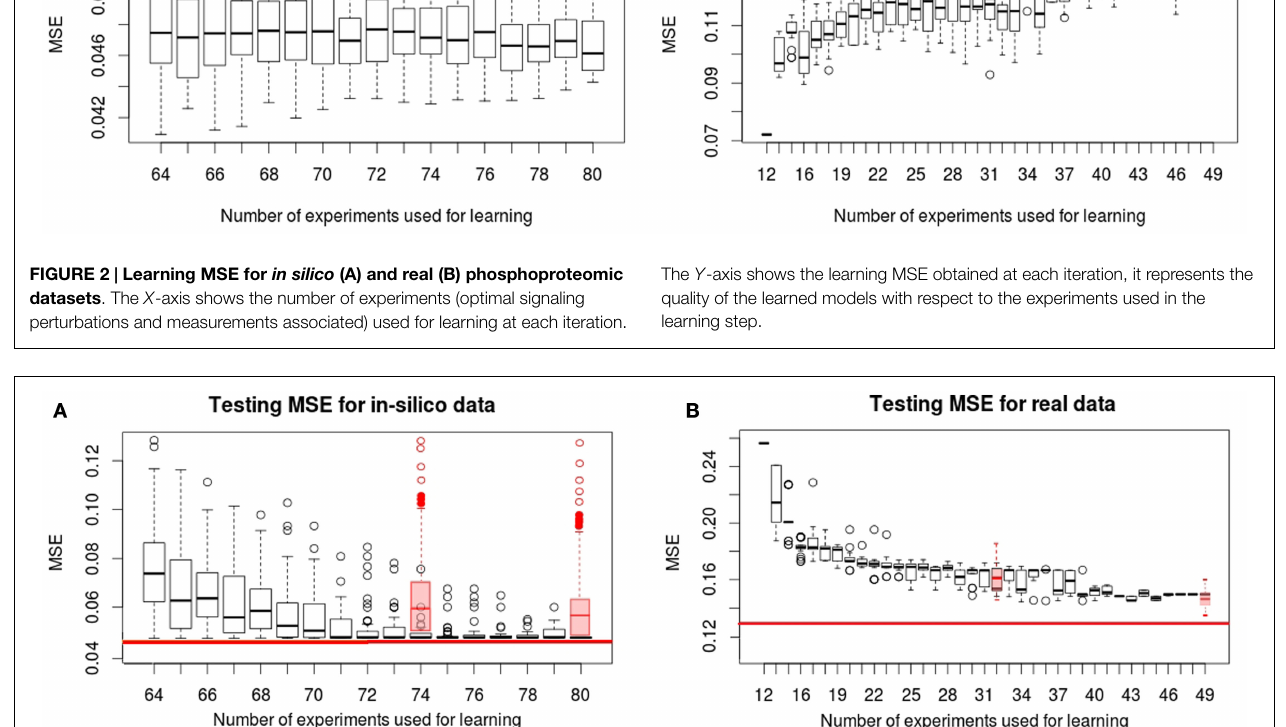
The Y -axis shows the testing MSE obtained at each iteration, it represents the quality of the learned models with respect to the full experimental dataset at each iteration. Red boxplots are the results obtained when the set of signaling perturbations was composed of randomly selected experiments of size 74 or 80 for the in silico case, and 32 or 49 for the real